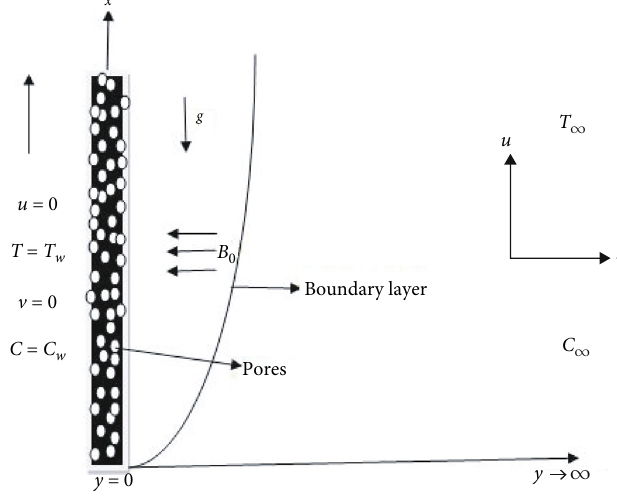
Figure 1: Physical con fi guration.